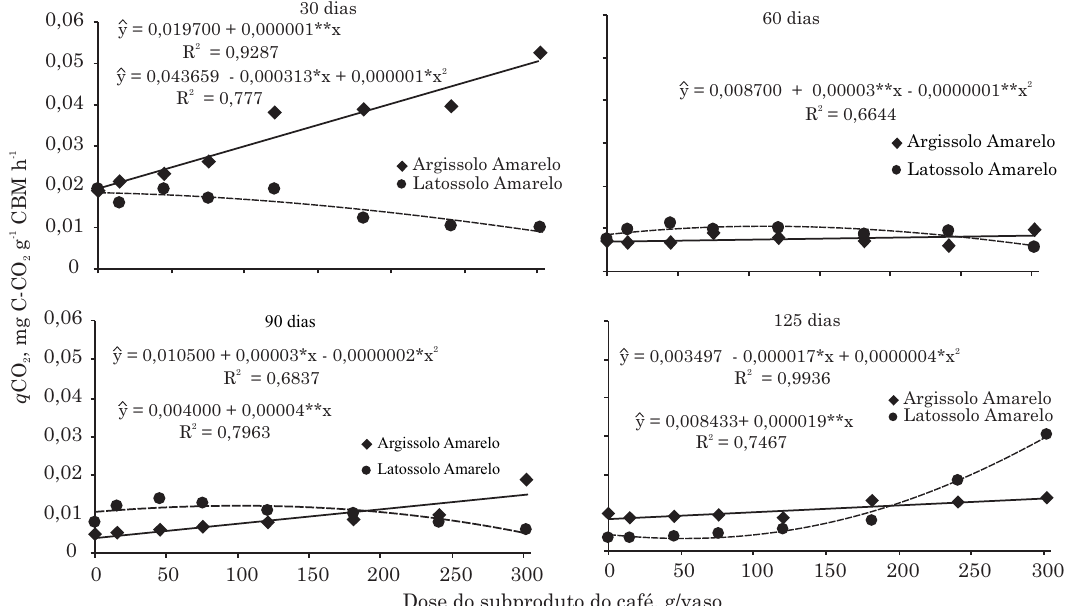
Figura 3. Quociente metabólico ( q CO 2 ) aos 30, 60, 90 e 125 dias de incubação nas amostras do Argissolo Amarelo e Latossolo Latossolo Amarelo, em função da aplicação de doses de subproduto de café e sob o cultivo de